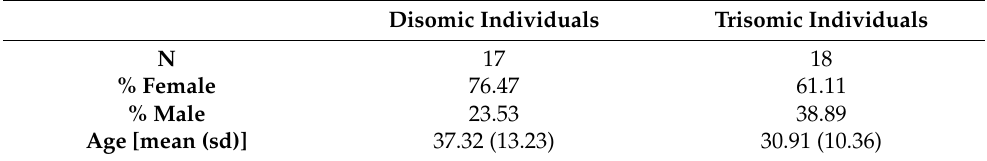
Table 1. Population Demographics. Disomic Individuals Trisomic